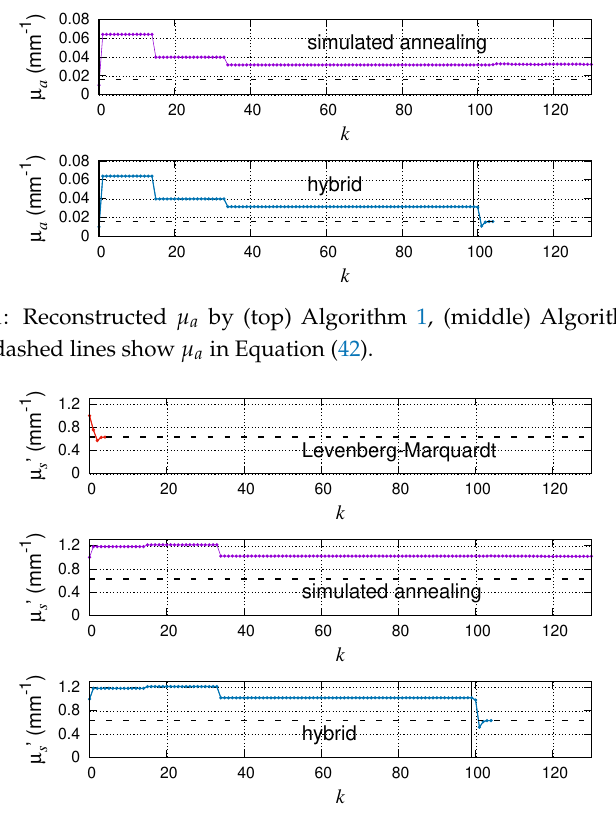
Figure 4. Case 1: Reconstructed µ (cid:48) s by (top) Algorithm 1, (middle) Algorithm 2, and (bottom) Algorithm 3. The dashed lines show µ (cid:48) s in Equation